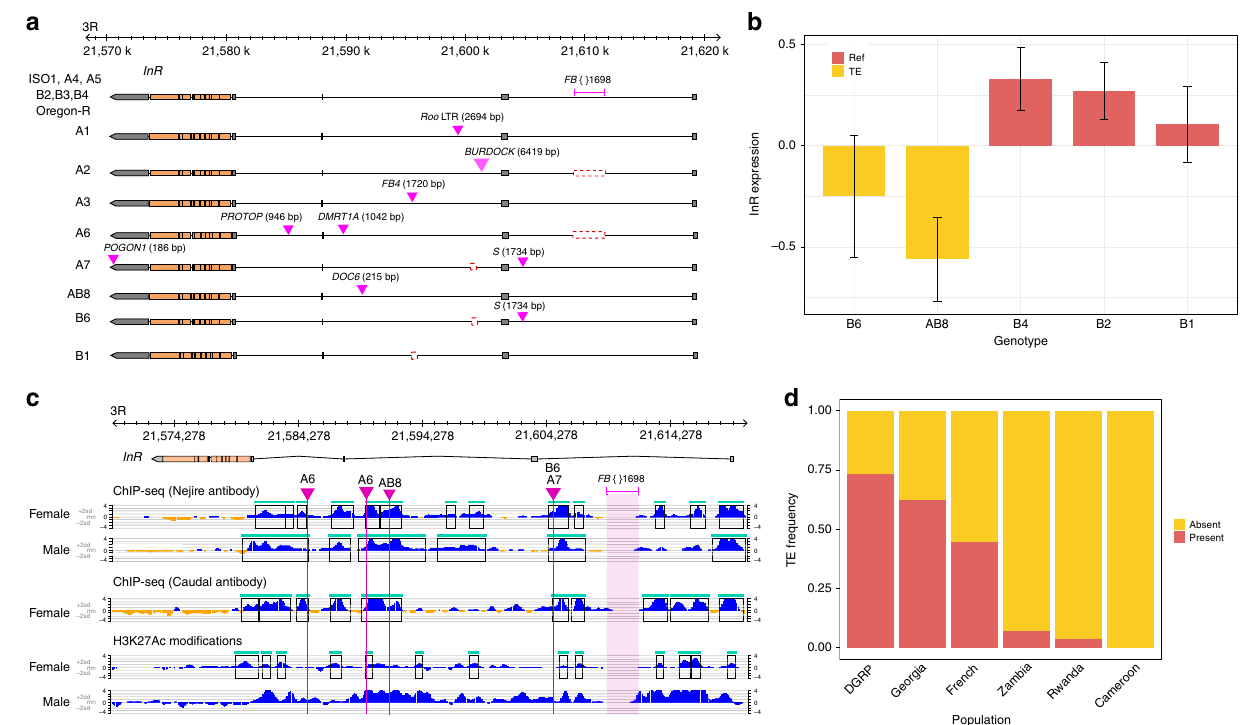
Fig. 4 SV allelic heterogeneity at InR and their functional consequences. a Eight structurally different alleles consisting of different intronic TEs at Insulin receptor ( InR ) gene. The reference TE FB{}1698 is present in all sequenced strains, except A2 and A6. In contrast, most of the other TEs are private to the founder strains carrying them. The S element in A7 and B6 and the Doc6 element in AB8 insert into known cis-regulatory sequence. b Expression level of InR in F1 hybrids between panel B RILs and the founder strain A4. RILs with AB8 and B6 genotype show downregulation of InR among the panel B genotypes. Both AB8 and B6 harbors TEs that insert into known cis-regulatory intronic sequence of InR. c Insertion of TE insertions into transcription factor binding sites (TFBS) for Caudal and Nejire. The top and middle panel shows the TF binding peaks detected from ChIP-seq performed with Nejire and Caudal antibodies, respectively. The bottom panel shows H3K27Ac histone modi fi cations representing a transcriptionally active state. The histone marks largely overlap with the TFBS, supporting the functional signi fi cance of the latter. High frequency FB{}1698 is inserted between two TFBS enriched sites. Disruption of TFBS by transposon insertion in B6 and AB8 InR alleles likely cause downregulation of the gene as shown in 3b. d Frequency of FB {} 1698 insertion in InR in different cosmopolitan and ancestral populations of D. melanogaster. The TE insertion is rare in the ancestral African populations but segregates in intermediate to high frequencies in the derived, cosmopolitan populations. Error bars indicate standard errors of genotypic